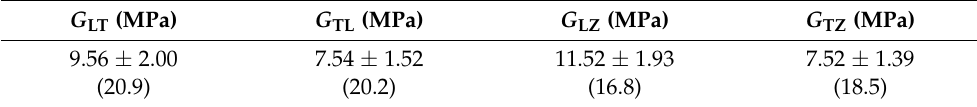
Table 6. G LT , G TL , G LZ , and G TZ values obtained from flexural vibration